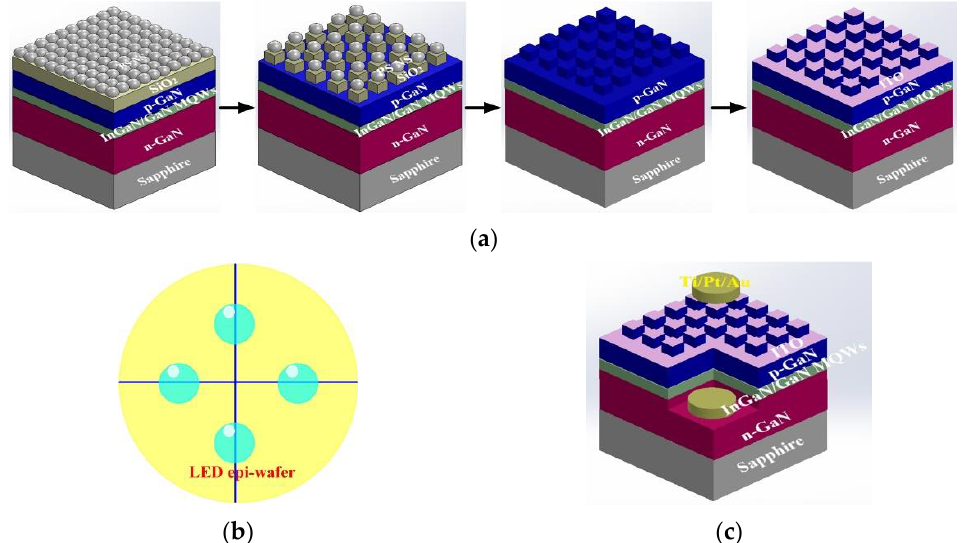
Figure 1. Schematic illustrations of ( a ) process of the PC-structured p-GaN nanorods, ( b ) positions on the substrate for the second-time spin-coating process, and ( c ) the finished device. Table 1. The parameters of the modified PS NS lithography process for the varied PS NS diameter. PS NS Diameter (nm)